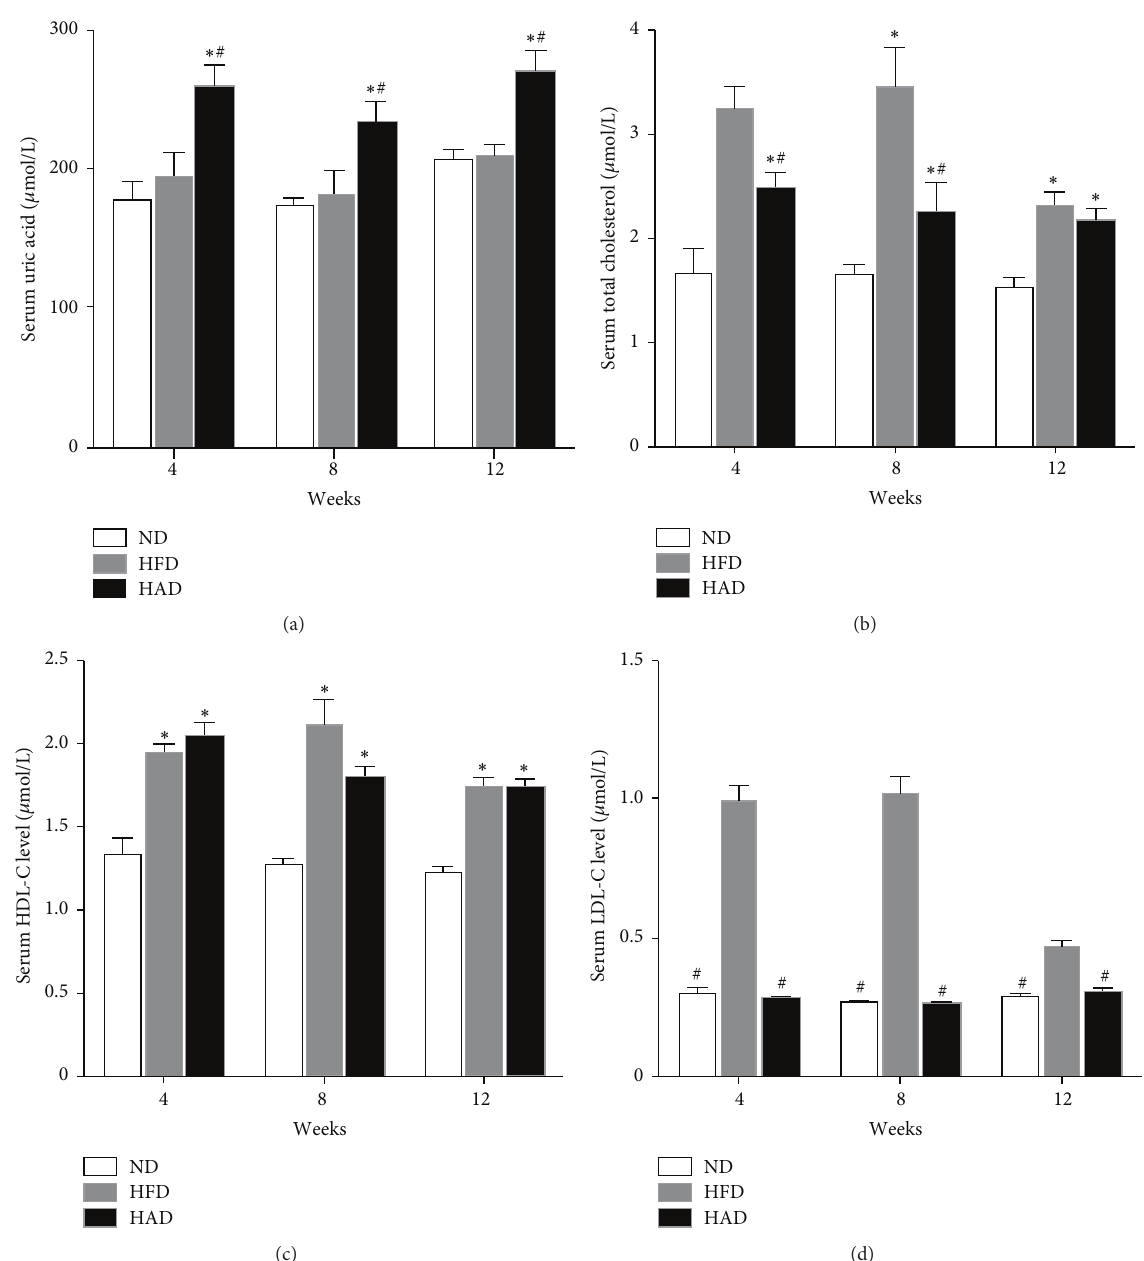
Figure 1: Serum uric acid and lipid levels in rats. Serum uric acid and lipid levels were analyzed using an autoanalyzer. (a) Serum uric acid, (b) serum TC, (c) serum HDL-C, and (d) serum LDL-C ( 𝑛 = 8 – 10 ). ∗ 𝑃 < 0.05 , compared with the ND group; # 𝑃 < 0.05 , compared with the HFD